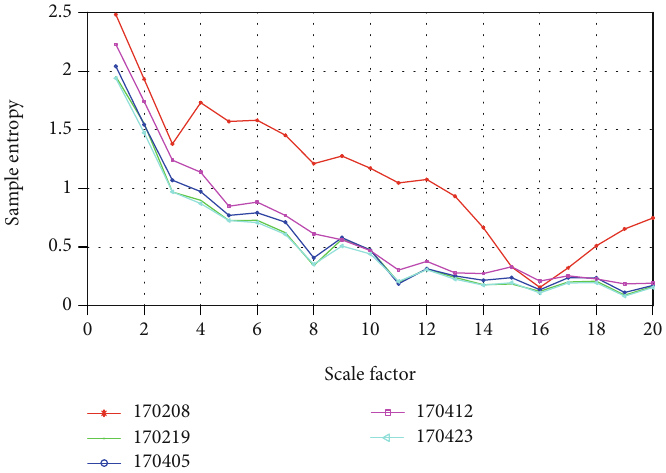
Figure 5: MSE analysis of the GWTC-1-marginal interval data recorded by L1